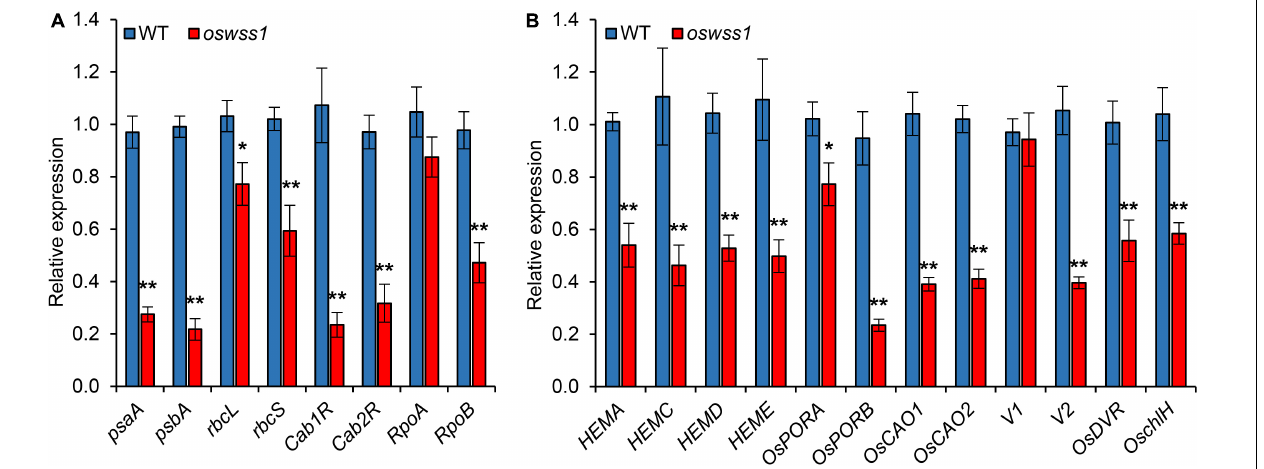
FIGURE 9 | The expression of genes related to chloroplast development, chlorophyll synthesis and photosynthesis altered in oswss1 mutant at the tillering stage (87 DAS) by qRT-PCR. (A) The expression of genes involved in photosynthesis between wild type (WT) and oswss1 mutant. (B) Transcriptional level analysis of expression of genes involved in chlorophyll synthesis and chloroplast development between WT and oswss1 mutant. OsActin was used as an internal control. The gene expression of WT was normalized to 1 after the normalization with the value of OsActin . Values are mean ± SD ( n = 3). * P < 0.05, ** P < 0.01 (Student’s t